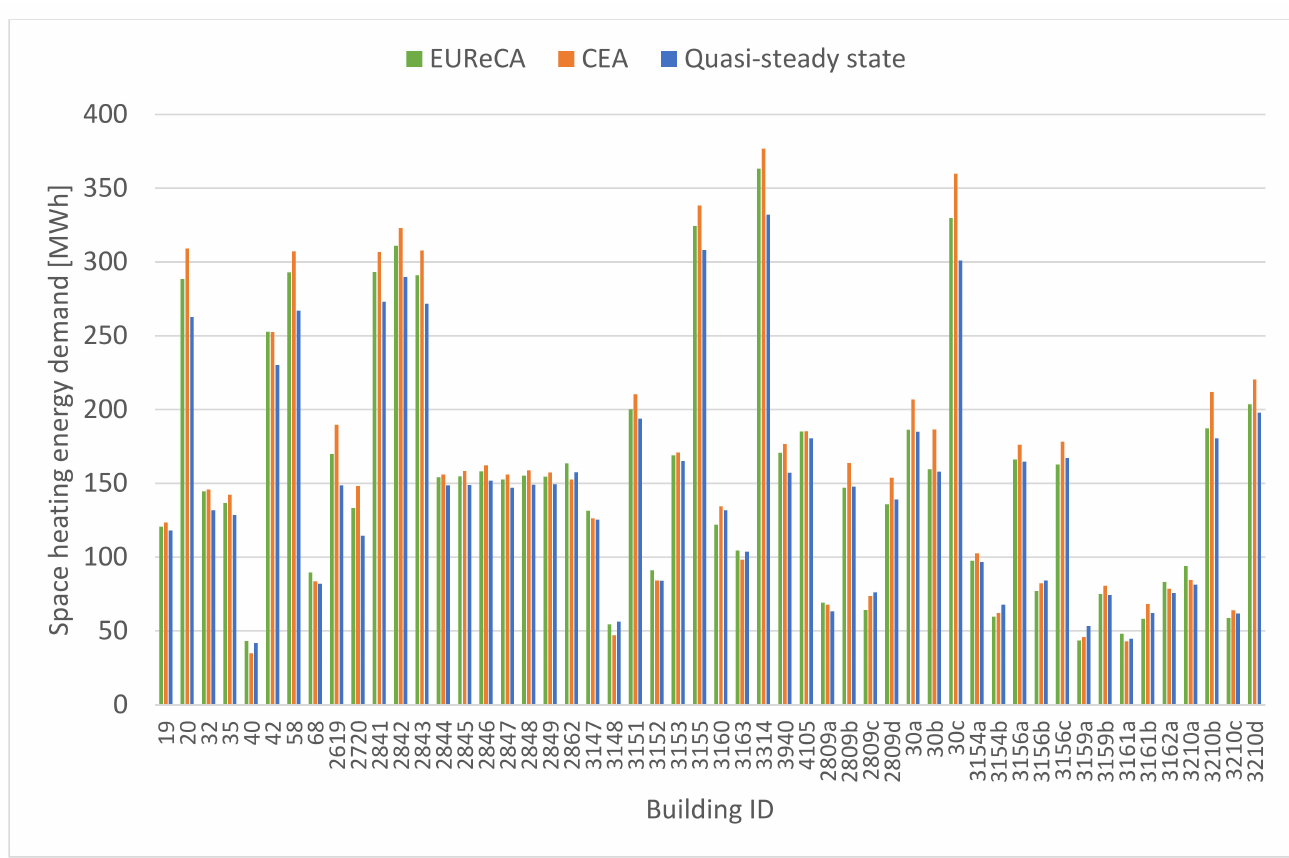
Figure 7. Evaluation of the space heating energy demand in the heating period considering transmission and ventilation